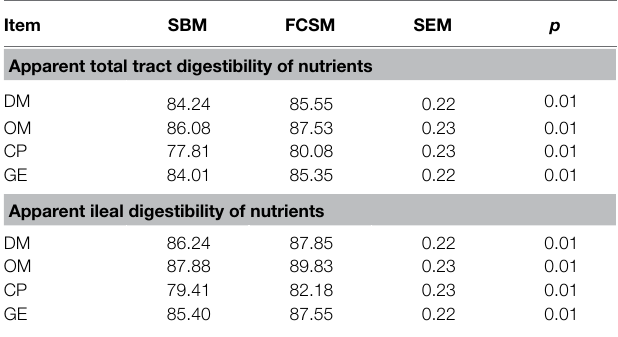
TABLE 3 | Effects of two protein source on performance of weaned piglets. Items SBM